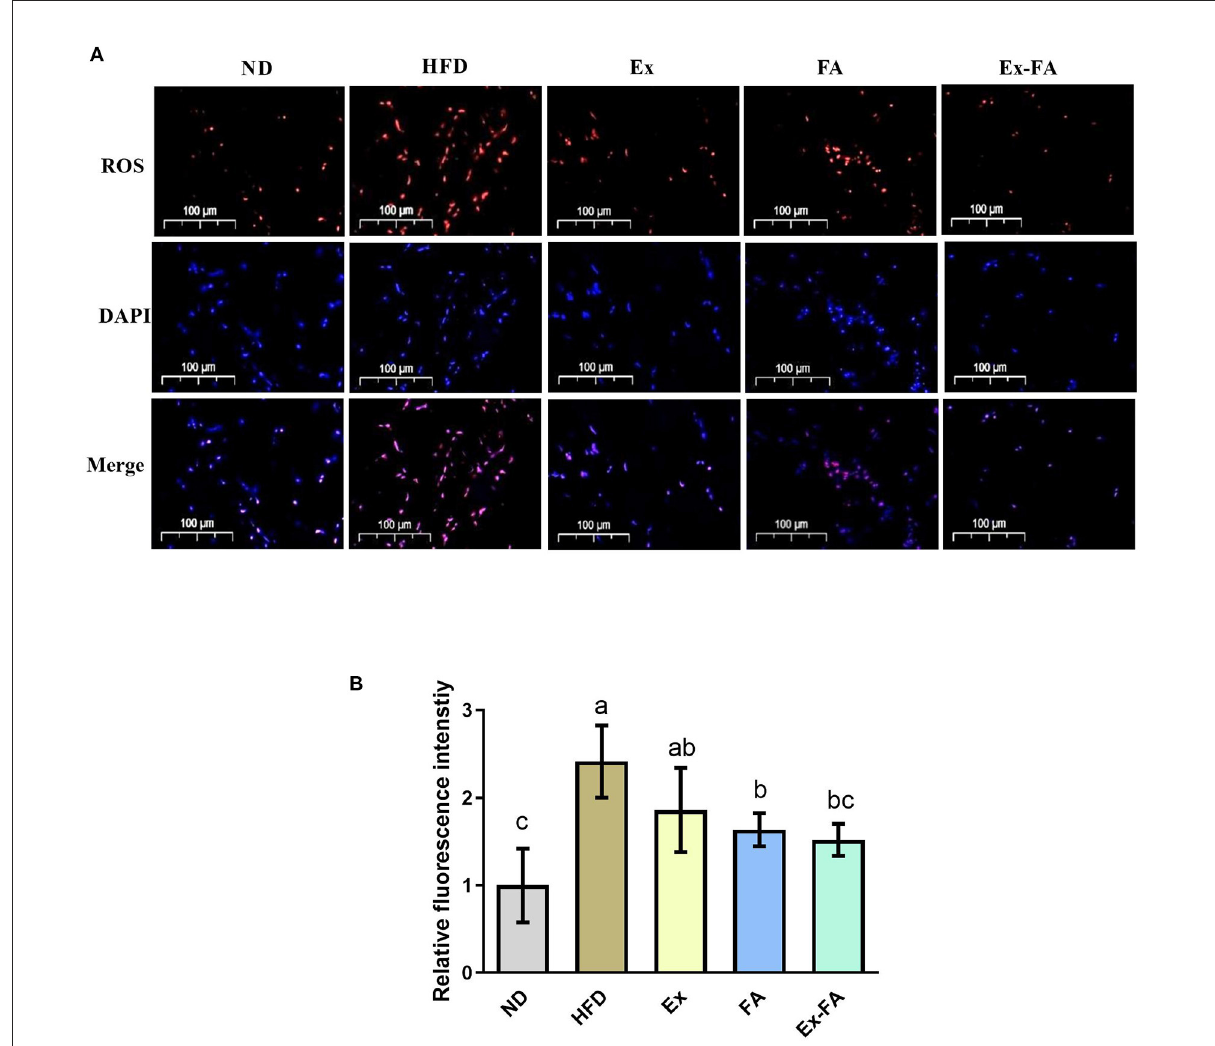
FIGURE4 Effects of Ex, FA, and Ex-FA on the ROS level in HFD-fed mice. (A) ROS and DAPI staining of skeletal muscle sections (scale bar = 100 µ m). (B) Relative fluorescence intensity. Nucleus labeled with DAPI were blue and ROS positive areas were red. ND, normal diet group (control); HFD, high-fat diet group (model); Ex, high-fat diet with exercise; FA, high-fat diet with ferulic acid; Ex-FA, high-fat diet with exercise and ferulic acid. Data are expressed as mean ± SD ( n = 6). Means with different letters are significantly different ( P <